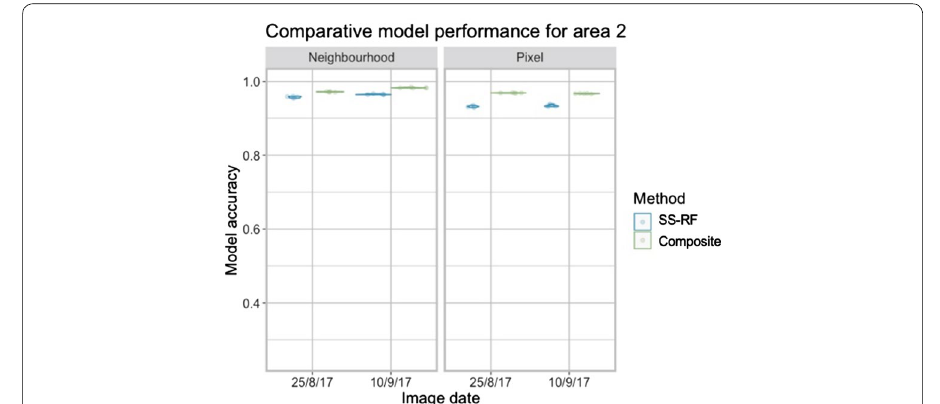
Fig. 10 Comparative accuracy of the SS‑RF and compositing approaches interpolating forest and not forest land cover classifications for area 2. SS‑RF results are shown by the blue violin plots and composite results are shown by the green violin